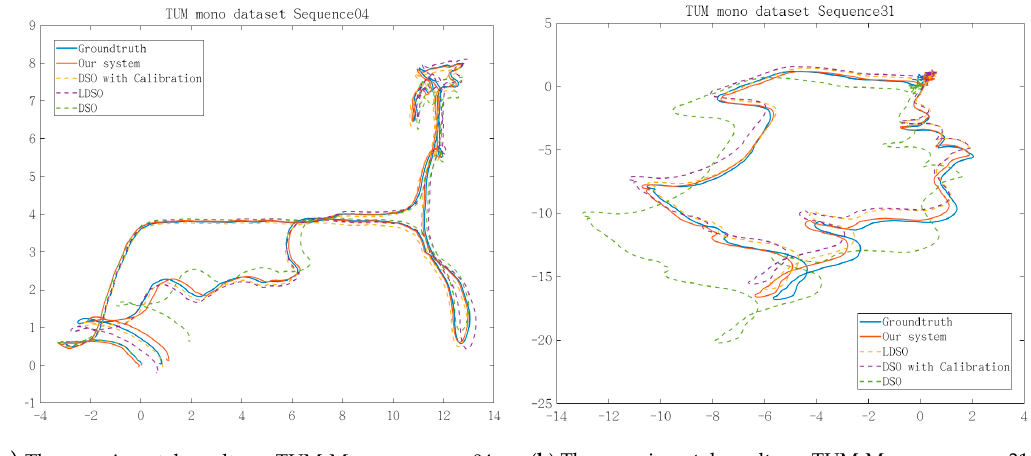
Figure 7. The experimental results on the TUM-Mono dataset. Subfigures ( a ) and ( b ) show the trajectories of sequences 04 and 31, respectively, along the x -axis and z -axis on our system. Down are direct sparse odometry (DSO); DSO with loop closure (LDSO); and enhanced DSO, which was integrated with the algorithms proposed in [12] and [14].